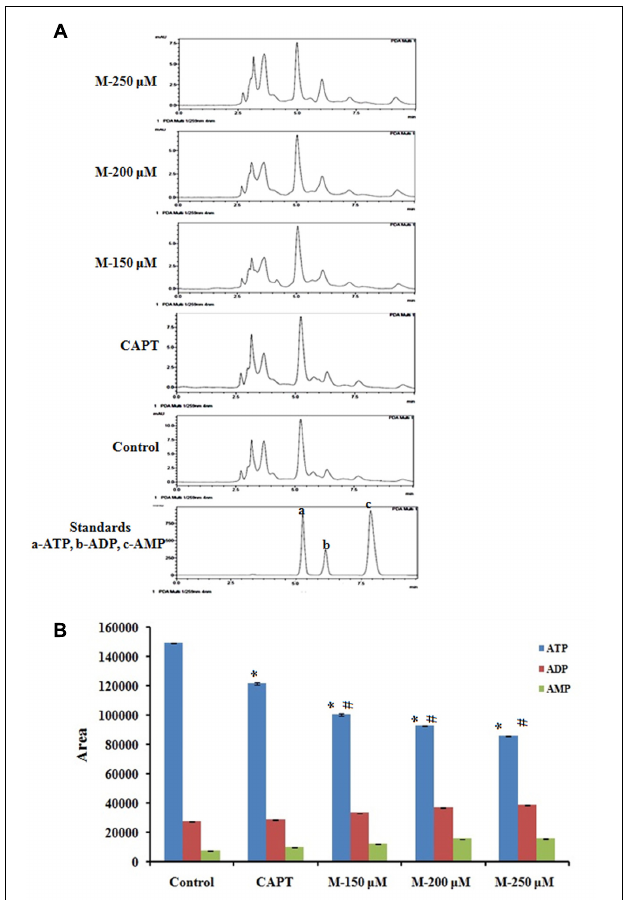
FIGURE 9 | Quantification of ATP level by HPLC method. SW480 cells were treated with various concentrations of morin (150, 200, and 250 µ M) and camptothecin (50 µ M) for 48 h. Morin treatment significantly decreases mitochondrial capacity to produce ATP. (A) Representative HPLC chromatogram showing decrease in ATP production in SW480 cells on treatment morin. (B) Graphical representation of reduction in ATP production by morin in SW480 colon cancer cells. CAPT: camptothecin (50 µ M), M (150, 200, and 250 µ M): Morin (150, 200, and 250 µ M). Each value represents mean ± SD from triplicate measurements and significance levels between different groups were determined by using one way ANOVA, ∗ p ≤ 0.05 versus Control; # p ≤ 0.05 versus